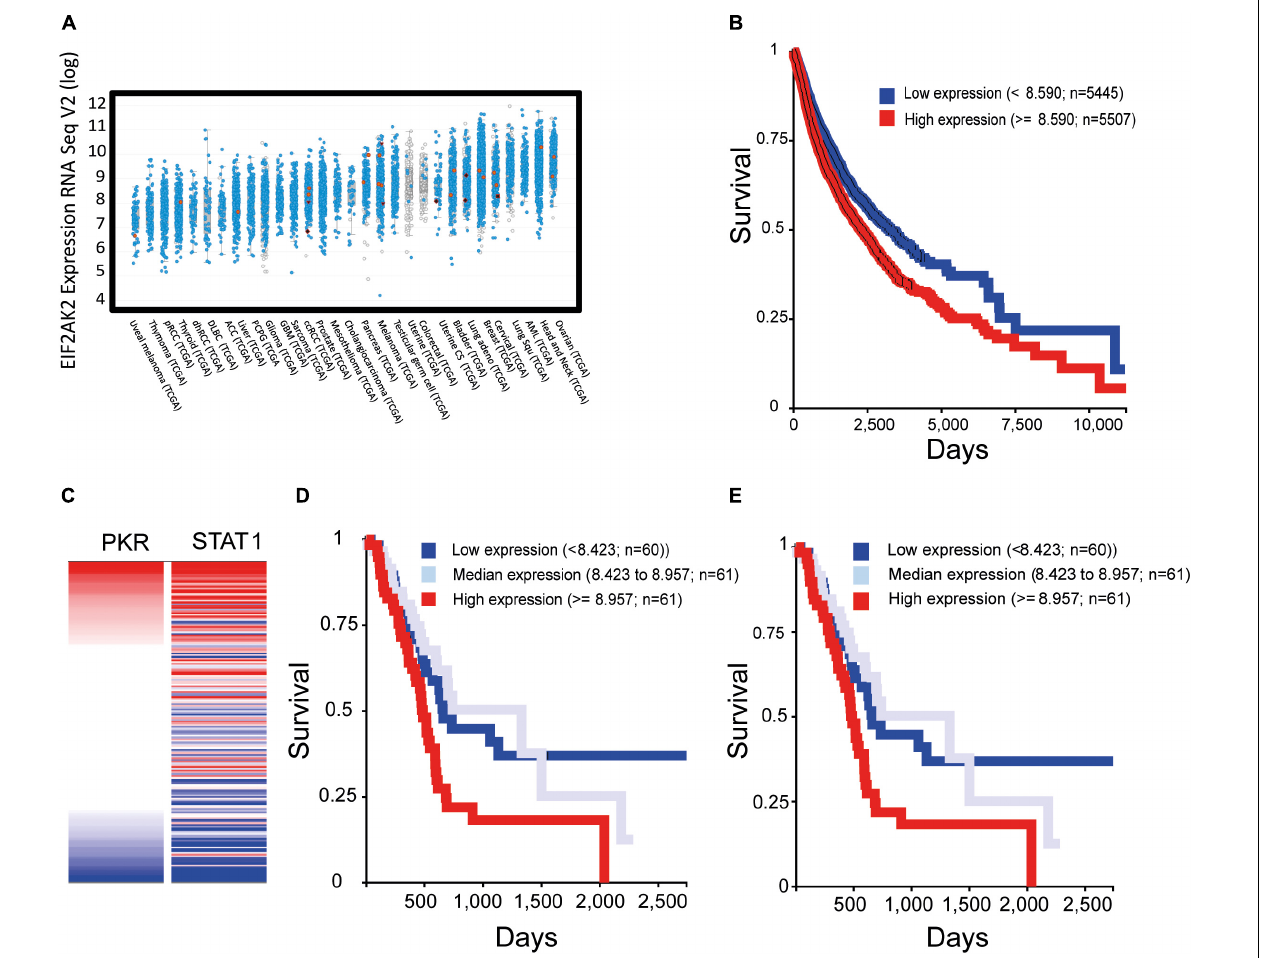
FIGURE 4 | Increased expression of PKR correlates with activation of interferon-STAT1 signaling and with poor prognosis in multiple cancer types. To evaluate the expression of EIF2AK2 (PKR) in samples of cancer patients, we employed cBio Portal to assess studies of The Cancer Genome Atlas (TCGA). (A) Expression of EIF2AK2. Graph depicts the RPKM value of EIF2AK2 expression in different patient samples, ordered according to the median value of expression in the given cancer type. Blue puncta are samples where the EIF2AK2 sequence is wild type, red are samples in which EIF2AK2 is mutated. (B) Analysis of survival of cancer patients according to EIF2AK2 expression. Graph depicts the survival of patients (12830 patients form the PANCAN TGCA database, assessed and visualized with the UCSC Xena browser) classified according to a threshold of EIF2AK2 expression (blue, low expression; red, high expression). (C) Correlation of expression of EIF2AK2 and STAT1 in pancreatic cancer patients (196 cases, PAAD TGCA study, visualized with the UCSC Xena browser). (D,E) Analysis of survival of pancreatic cancer patients according to EIF2AK2 (D) or STAT1 (E) expression. Graph depicts the survival of patients (196 patients form the PAAD TGCA database, assessed and visualized with the UCSC Xena browser) classified according to threshold expression (blue, low expression; gray, median expression; red, high